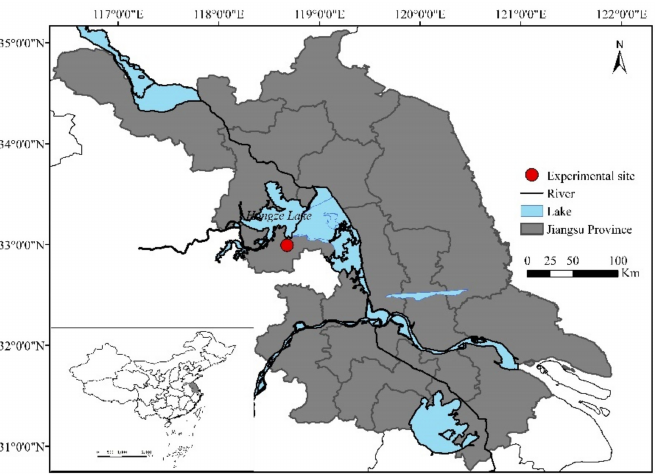
Figure 1. Location of the experimental site.